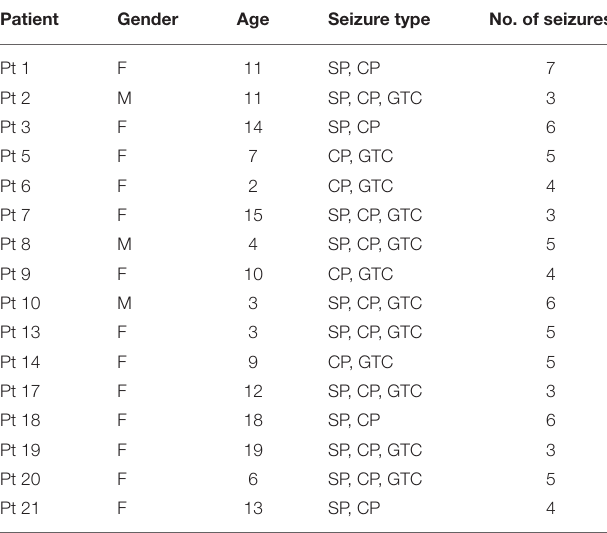
TABLE 2 | Details of the CHB-MIT test